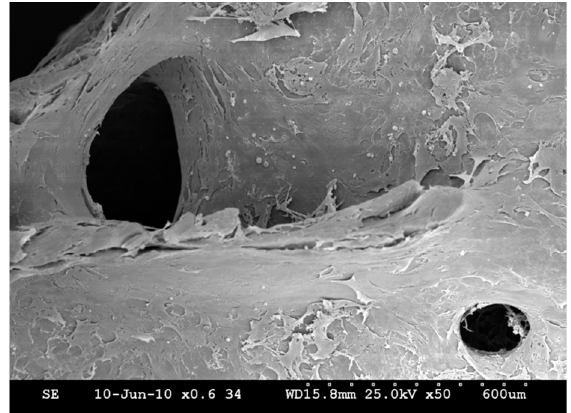
Figure 2. SEM picture of HA scaffold with USSC at day 10.